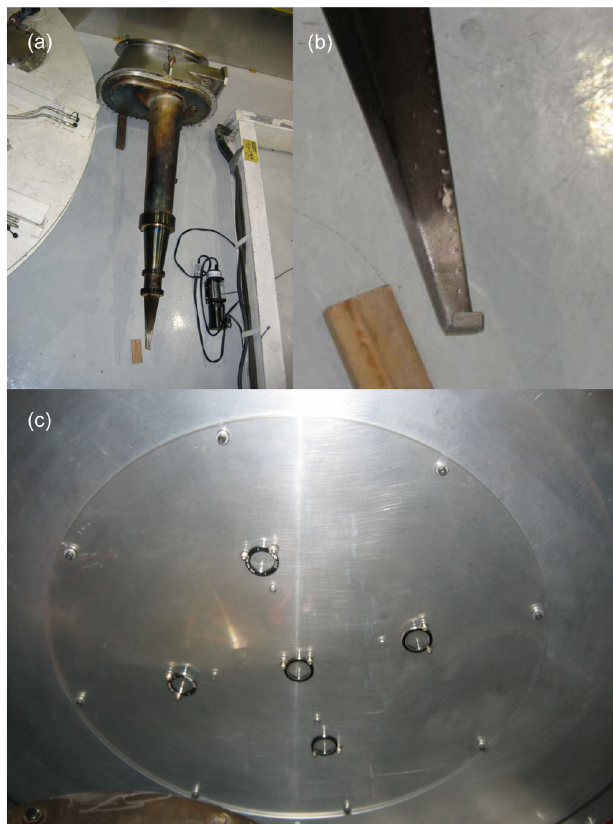
FIG. 7. (Color) (a) Complete FOA focusing cone after a Z shot. (b) Enlarged lower focusing cone. One can see that the rivets are facing away from the debris source and that the flapper closed properly on this shot. (c) View up into the focusing cone. All nitrocellulose samples are intact and in pristine condition. No dust is visible on the nitrocellulose or on the aluminum base plate.